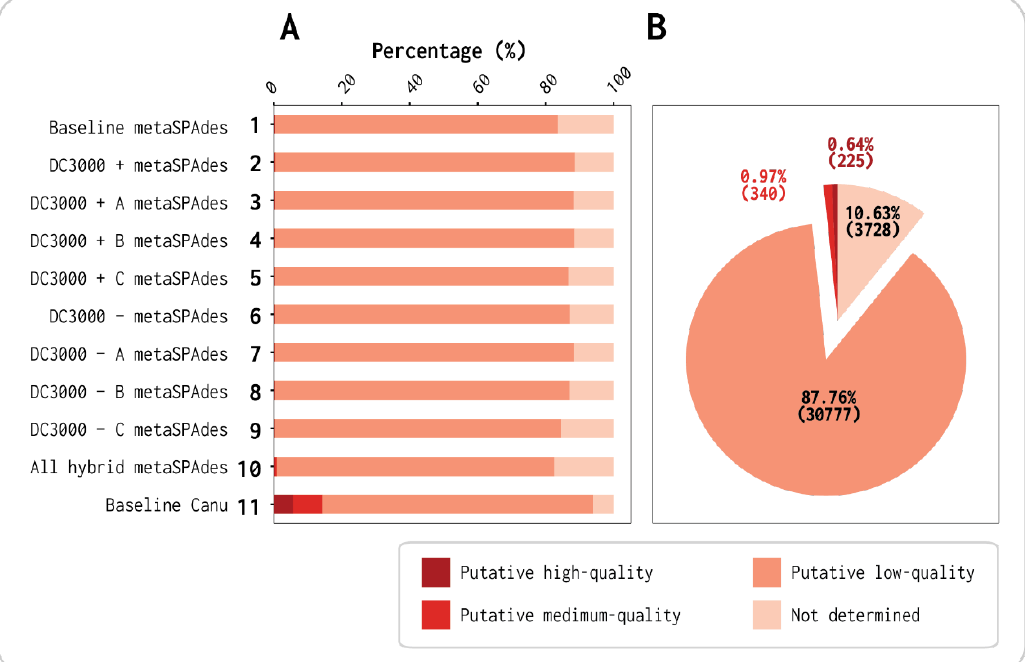
of the 11 assemblies; ( B ) percentage of quality distribution of viral contigs for joined assemblies.